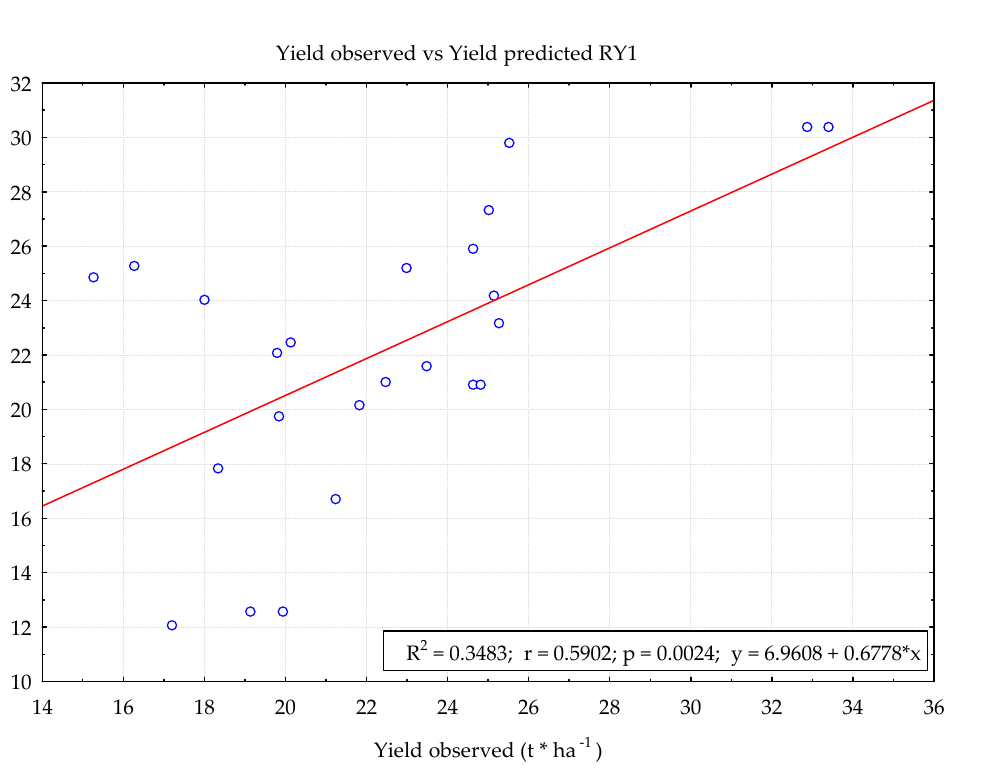
Figure 4. The scatter plot between observed and predicted values according to the RY1 model using Bp subset data.